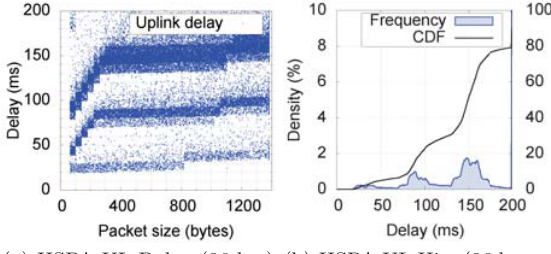
Figure 6: HSPA uplink delay results for 36 hours